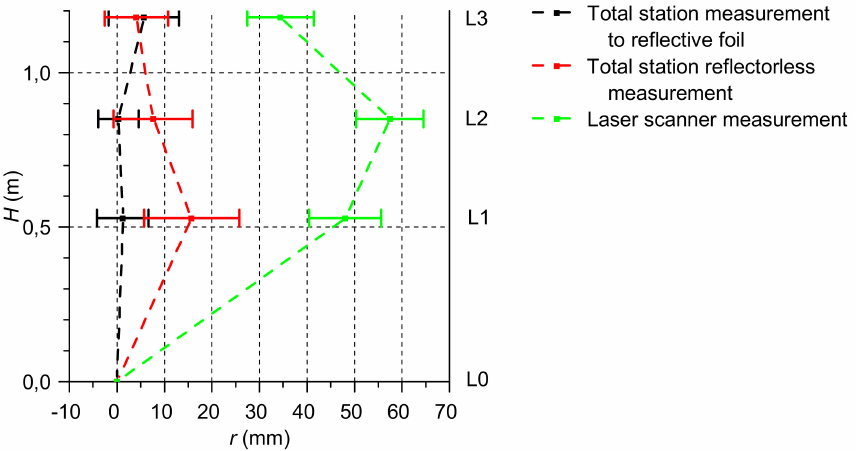
Figure 7. Deviation of cross-sectional centers from vertical line at considered measurement